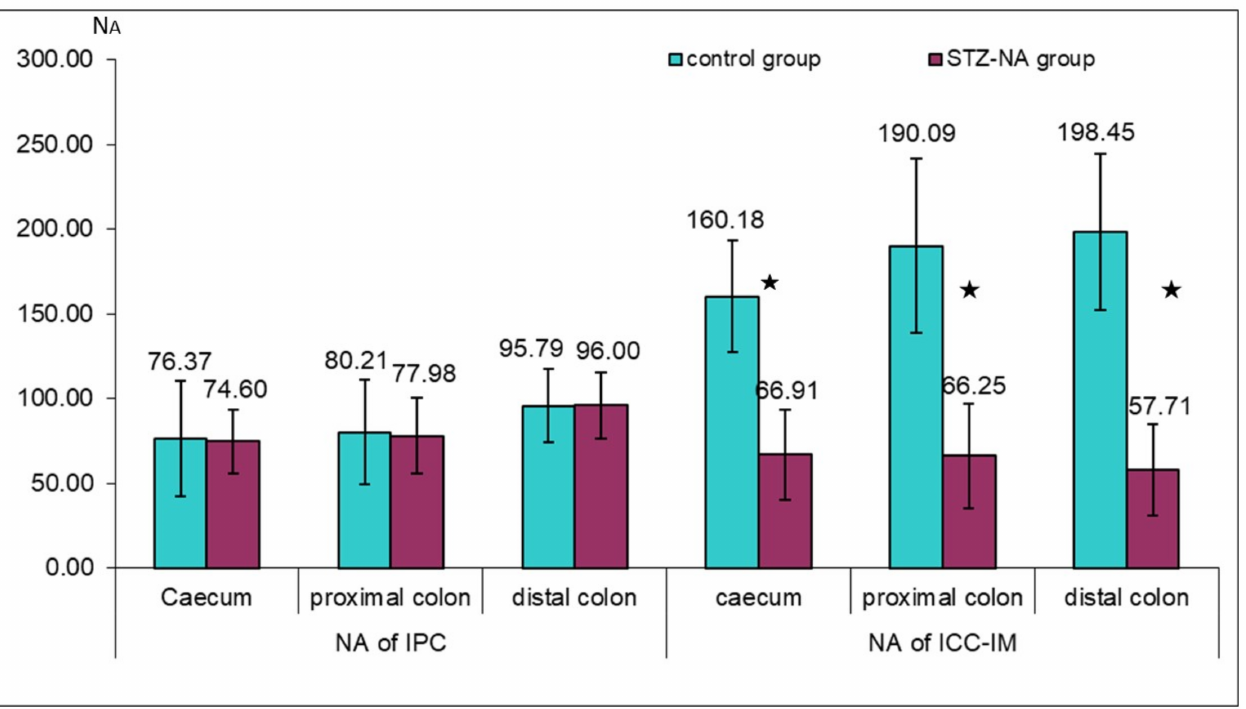
Figure 3. Numerical areal density (N A ) of IPC and ICC-IM in the circular muscle layer of the rat colon in control and STZ–NA group. Numerical values presented in the figure correspond to the mean values of the NA of IPC and NA of ICC-IM, (cid:70) statistical significance ( p ≤ 0.001).